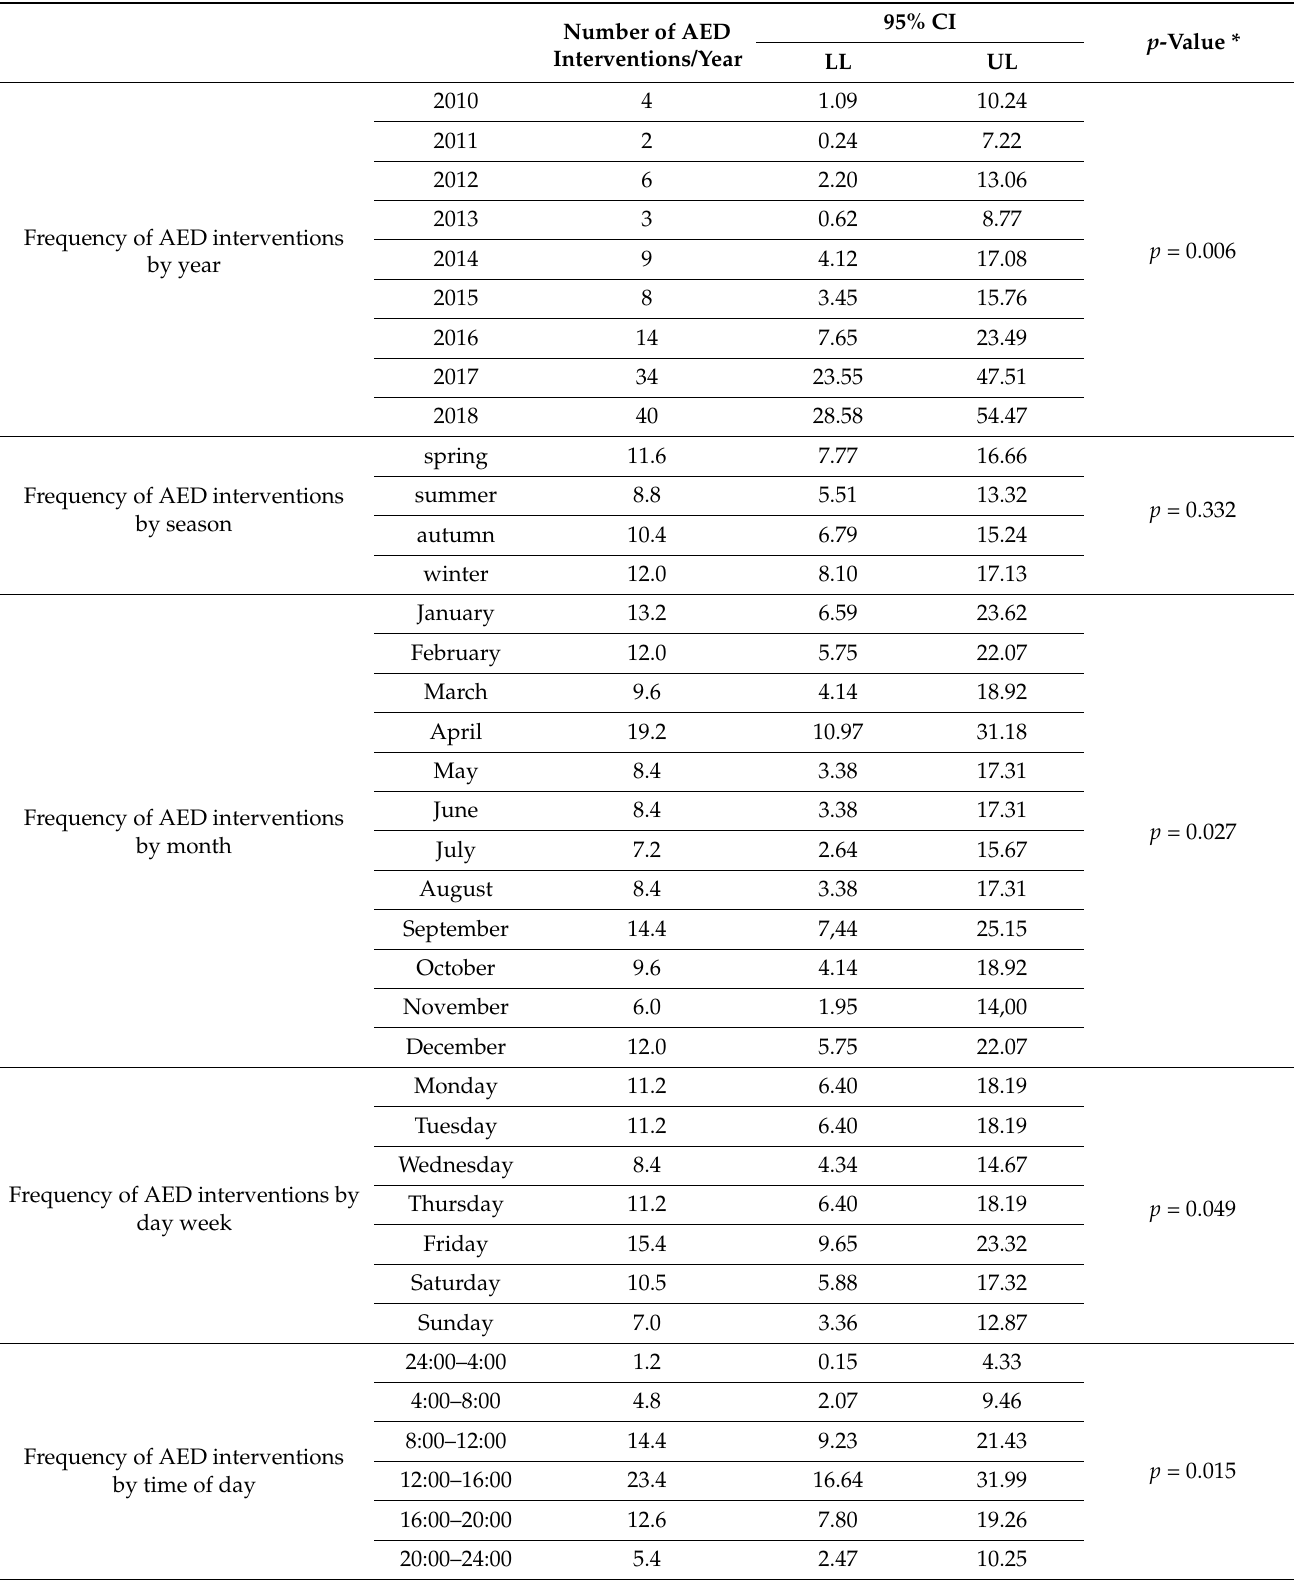
Table 3. Frequency of AED interventions varied by year, month, day of week, season, and time of day.